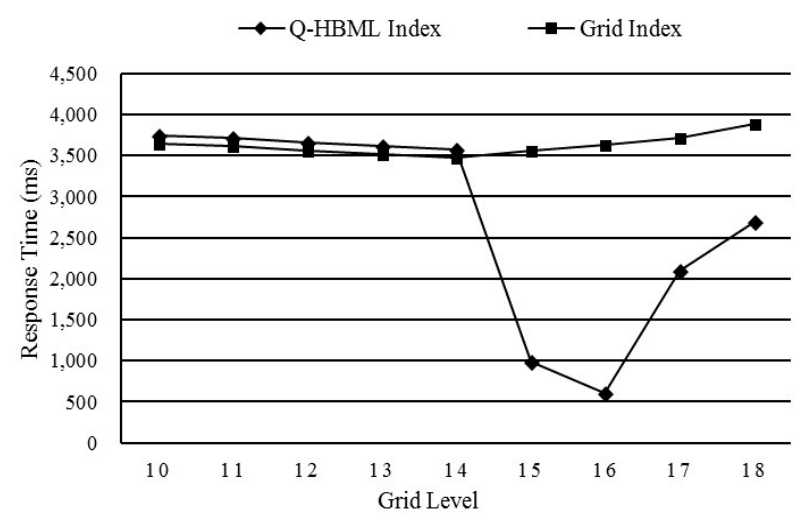
Figure 17. Region query efficiency with the Q-HBML index and the regular grid index.